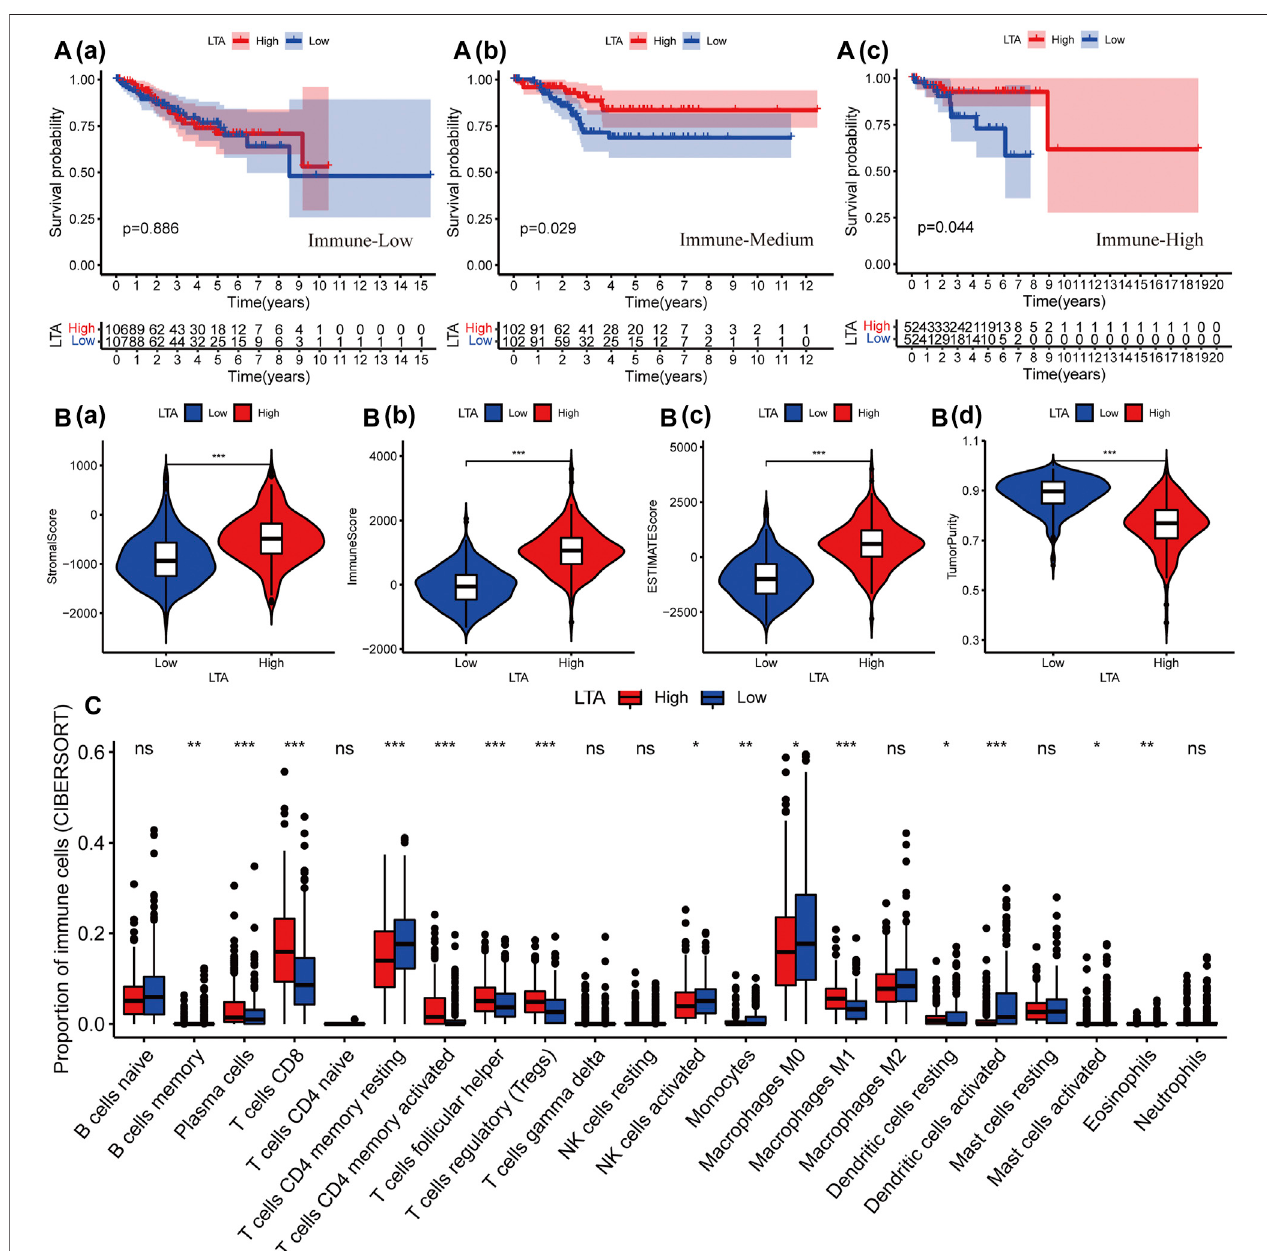
FIGURE3| EffectofLTAon immune characteristics. (A) Theeffect ofLTA onthesurvivaloutcomeofpatients inthree immunotherapy cohorts, “ immune-Low ” (a) , “ immune-Medium ” (b) ,and “ immune-High ” (c) .ThedifferenceofTME (B) andTILs (C) betweenhigh-LTAandlow-LTAexpressiongroups.The p -valueswerelabeledby asterisks (ns, no signi fi cance, * p < 0.05, ** p < 0.01, *** p < 0.001).